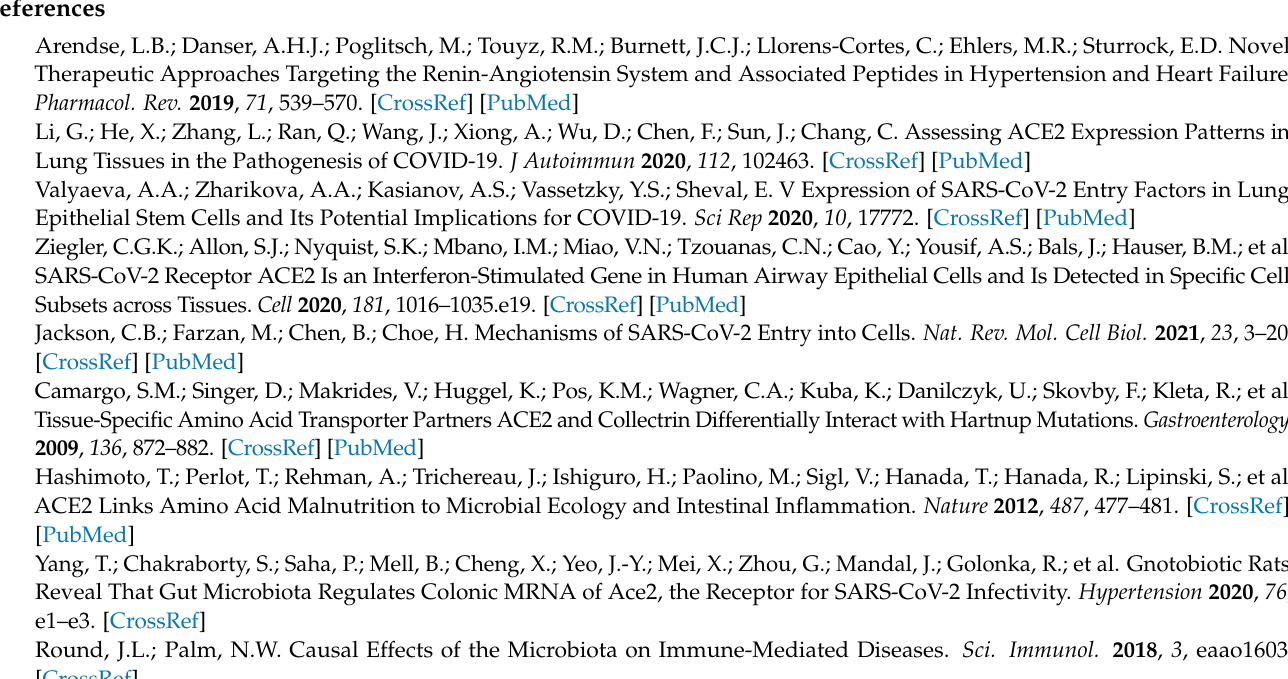
Supplementary Figure S2. Direct correlation between CGC and GPBAR1 expression in human colon samples. The data have been extrapolated from RNA-seq analysis of colonic biopsy samples from HMP2 project CD, UC and non-IBD patients. Each dot represents a patient. The graph represents a correlation analysis between GCG and GPBAR1